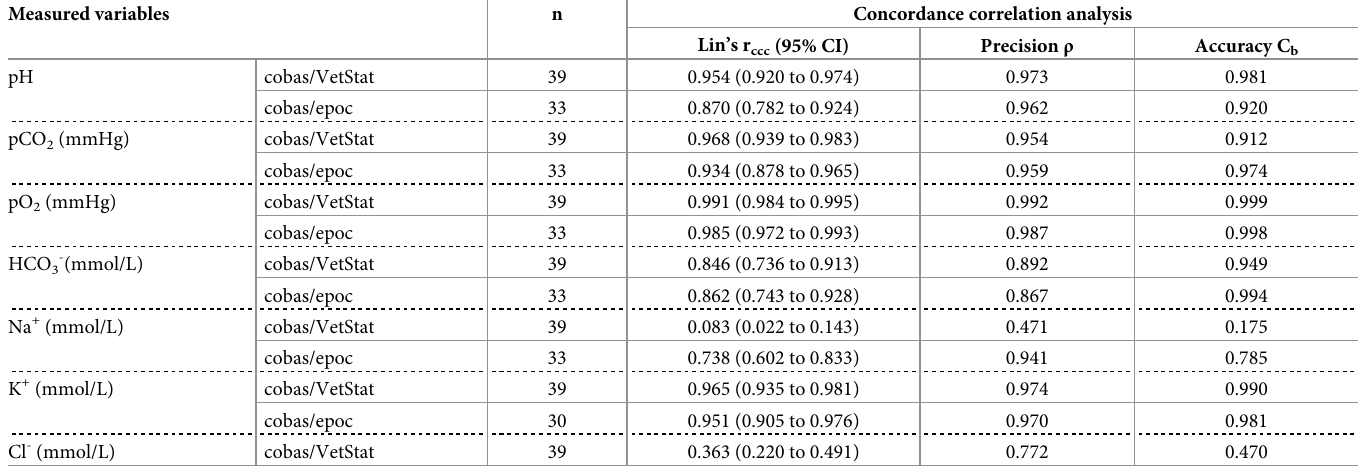
Table 1. Concordance correlation analysis between the portable analyzers VetStat ( n = 39; 30 arterial, 9 venous) and epoc ( n = 33; 24 arterial, 9 venous) and the cobas b 123 analyzer. Lin’s concordance correlation coefficients (r ccc ) with 95% confidence intervals (95% CI), precision (Pearson ρ ) and accuracy (bias correction factor, C b ) are